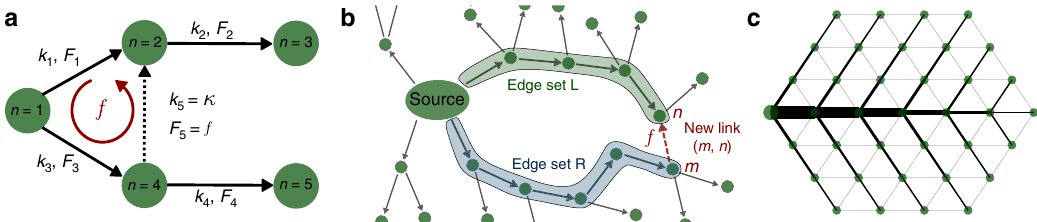
Fig. 2 Graph set up to analyse the transition from tree networks to loopy networks. a Elementary network to study spontaneous loop formation in optimum supply networks. The network consists of fi ve nodes (green circles) where node n = 1 has an in fl ow of four, P 1 = 4, and all other nodes have an out fl ow of unity. These in and outputs determine the fl ows F i , i ∈ {1, 2, 3, 4, 5} along with the links with capacities k i . The optimum topology for this set-up is a tree network. If the in- and outputs are fl uctuating, an additional edge (dotted arrow) may be bene fi cial to reduce the average dissipation. This edge introduces a new degree of freedom expressed as a cycle fl ow f . b For a larger network, we generalise this setup as follows: we start from a tree network and then consider the impact of a new edge at an arbitrary position ( n , m ) (dotted, red arrow). We then collect the edge sets L (shaded green) and R (shaded blue) along the shortest path from the source to the newly formed edge. This edge induces a cycle fl ow f . c A network formed from a triangular grid with a set of potential edges E coloured in grey which we will analyse throughout the manuscript. Realised edges (black) correspond to a global minimum of the dissipation for the fl uctuating sink model where a single, fl uctuating source (large circle) supplies the remaining (cid:1) ¼ (cid:2) that all nodes but one are sinks with P P supplied by a j> 1 (cid:1) ¼ ð N (cid:2) 1 Þ P , where N is the number of nodes. single node with P 1